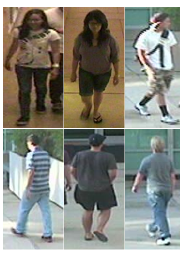
Figure 4. CHUK 03 dataset exemplary samples.